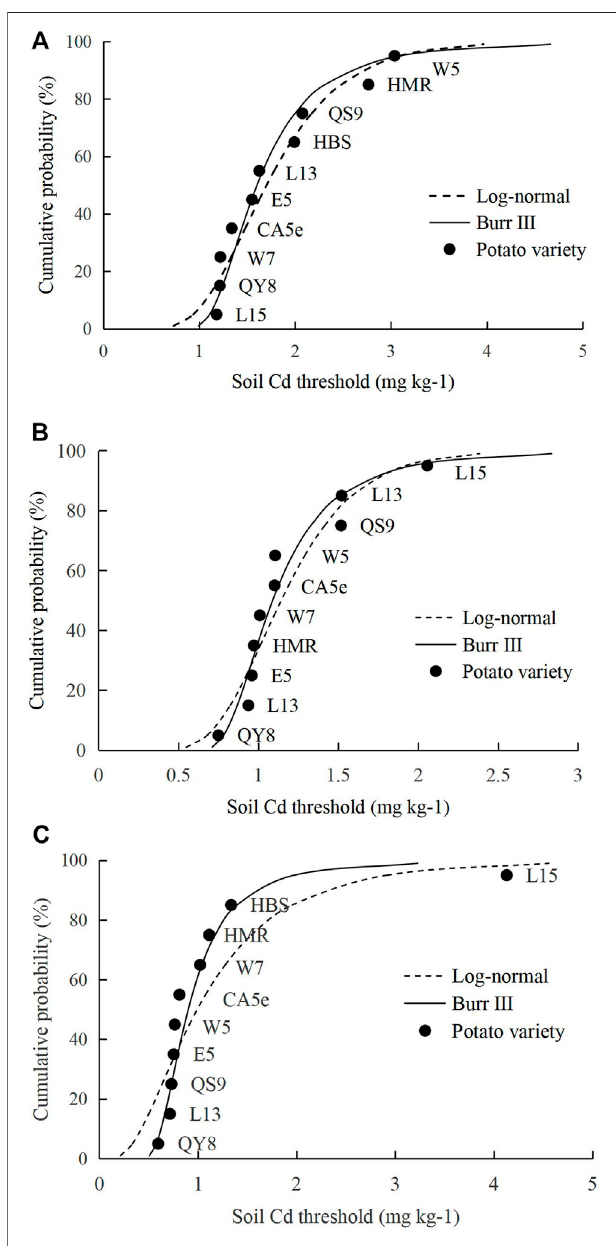
FIGURE 4 | SSD curves of different potato varieties in Guiyang soil. (A) . BAF ck , (B) . BAF total , (C) . BAF add